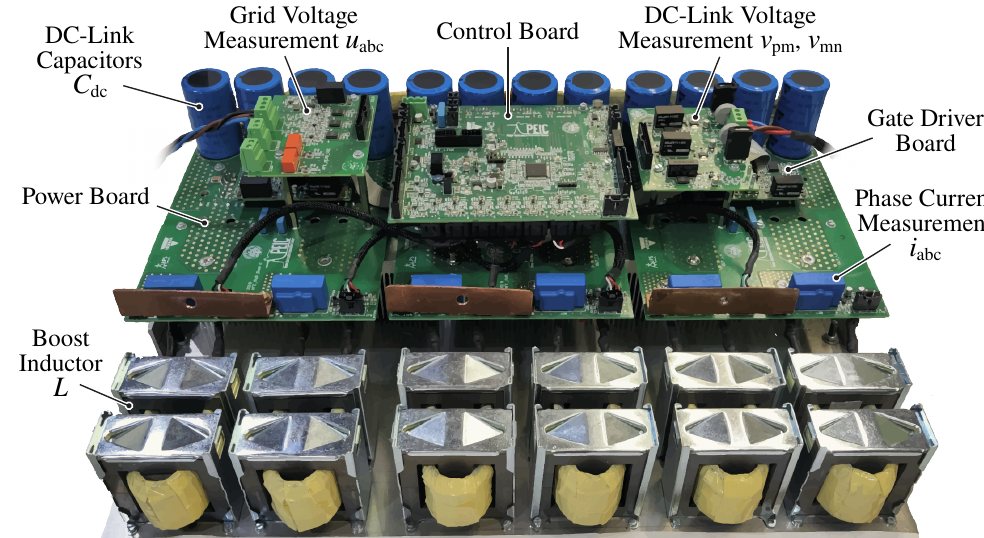
Figure 11. Overview of the three-level unidirectional T-type rectifier prototype used for the experi- mental tests. The converter consists of two paralleled 30kW units: only one unit is exploited for the experimental verification, due to the maximum power limitation of the available